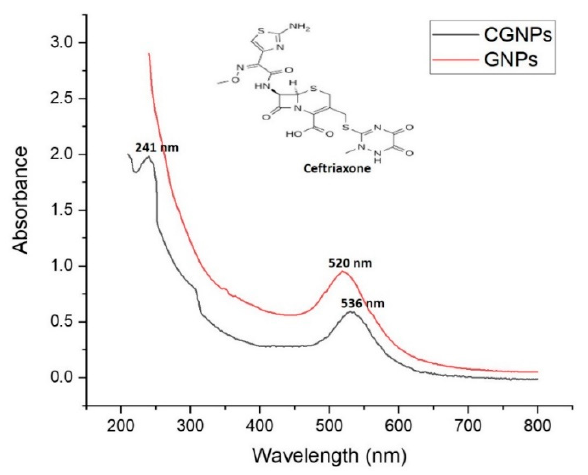
Figure 2. UV-Visible spectrophotometric characterization of GNPs and CGNPs.